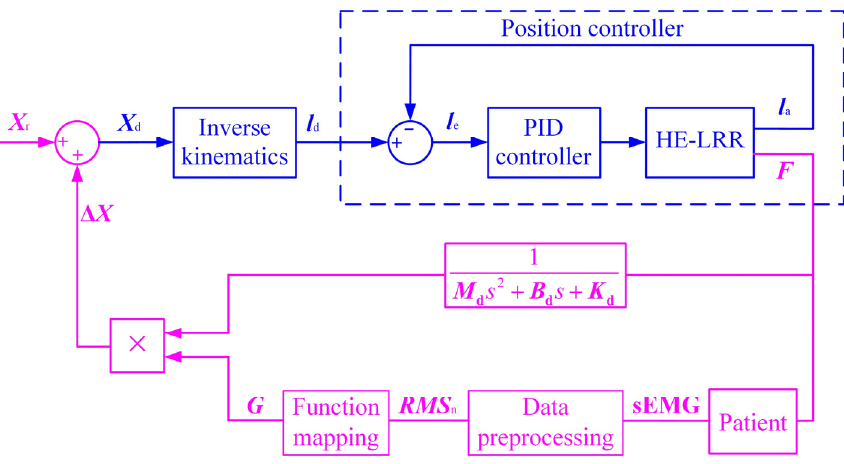
Figure 3. EGCC strategy diagram for the HE-LRR.